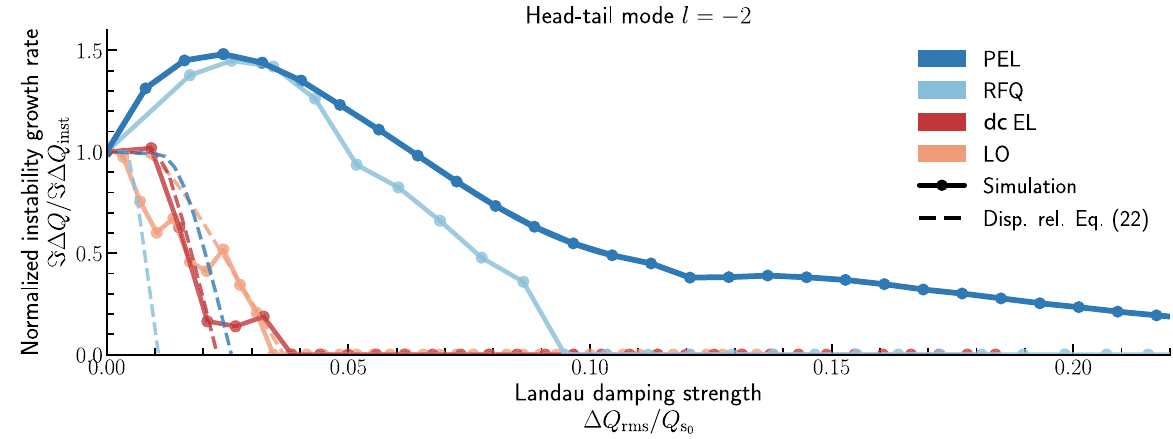
=Q for head-tail mode l ¼ − 2 . A PEL (dark- rms s 0